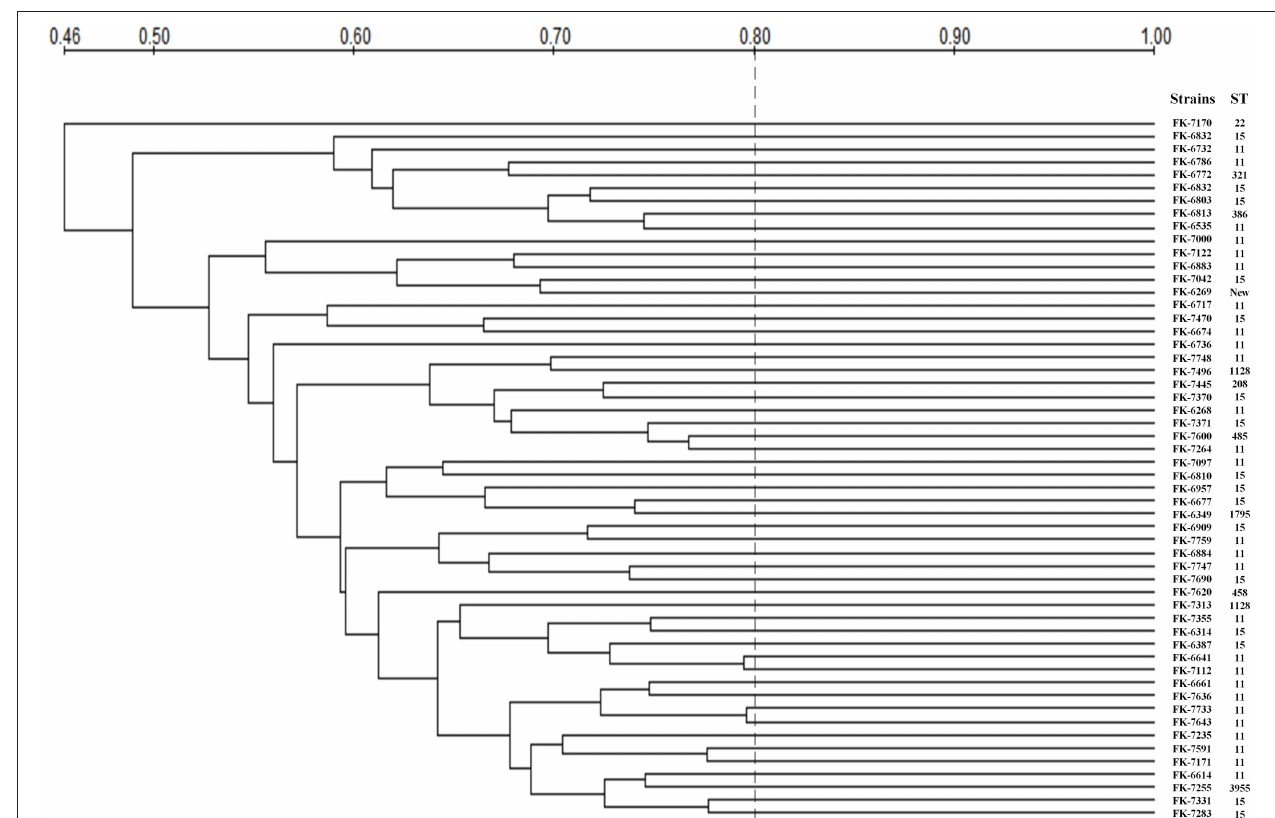
FIGURE 6 | PFGE profile and MLST of 54 intestinal CRKP strains. New, New ST.